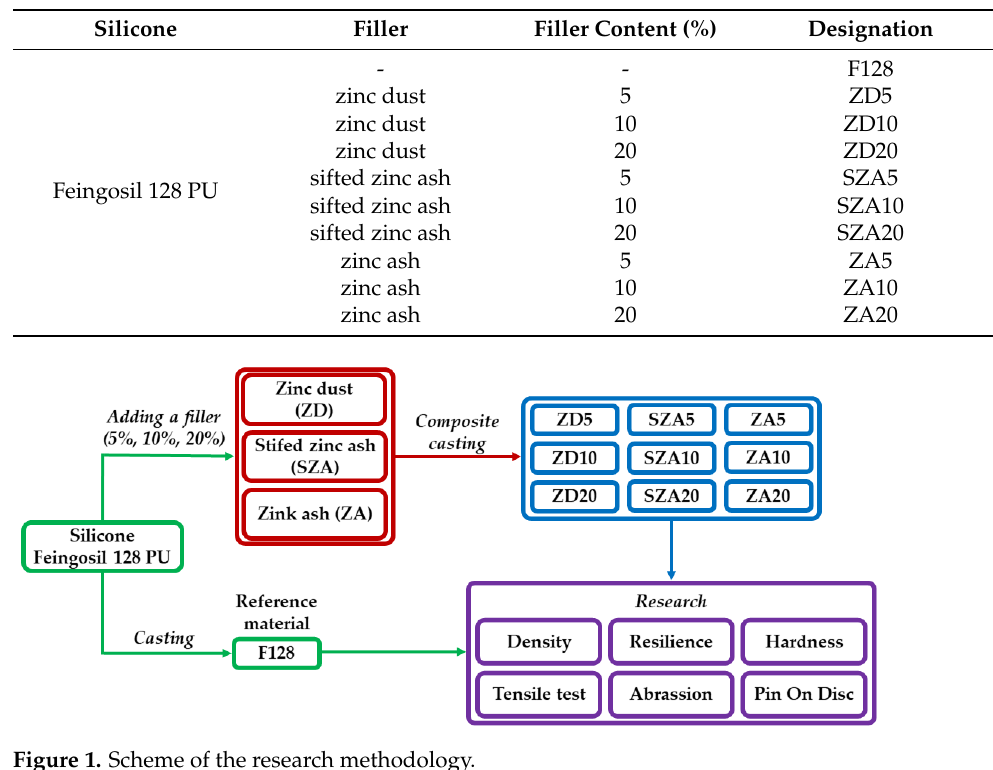
Table 1. Sample composition.